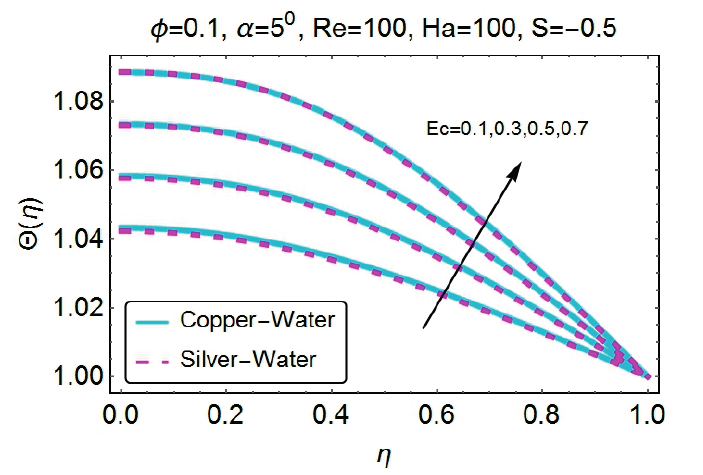
Figure 25. Change in temperature for varying Ec (divergent channel/shrinking case).